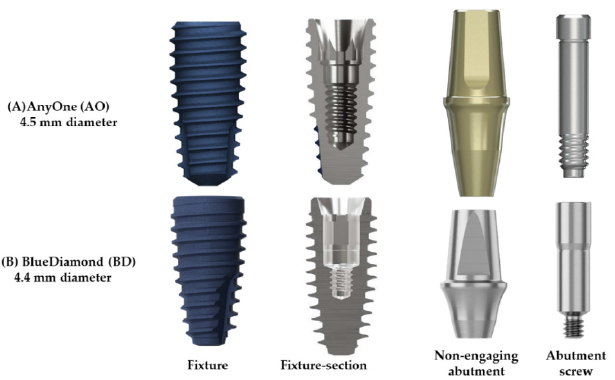
Figure 1. Schematic diagram of the fixtures. ( A ) AnyOne ® fixture with 22° connection angle; ( B ) BlueDiamond ® fixture with 30° connection angle.